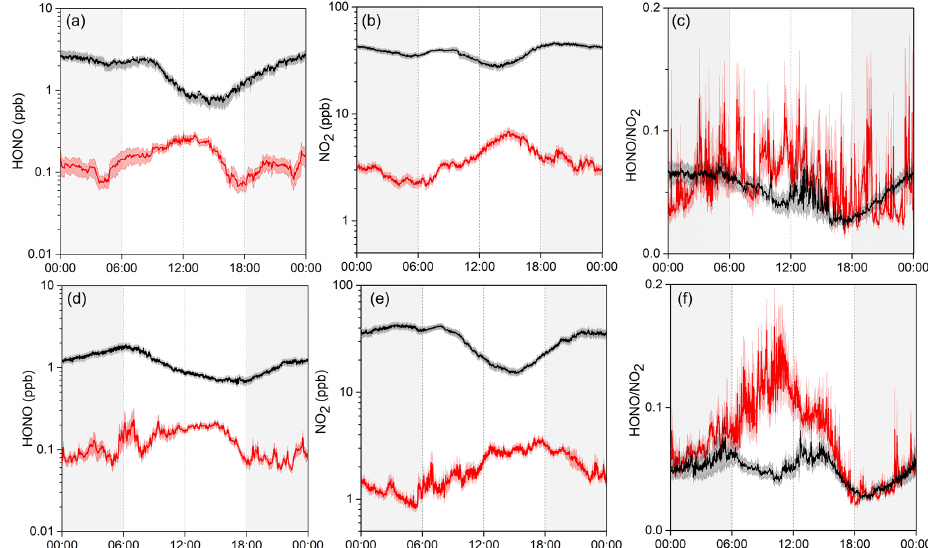
Figure 3. Comparison of the average diurnal variations of HONO, NO 2 , and HONO / NO 2 at Mt. Tai (red) and in urban Ji’nan (black) in winter (upper panel) and spring (lower panel). Shaded area indicates the standard error of measurement